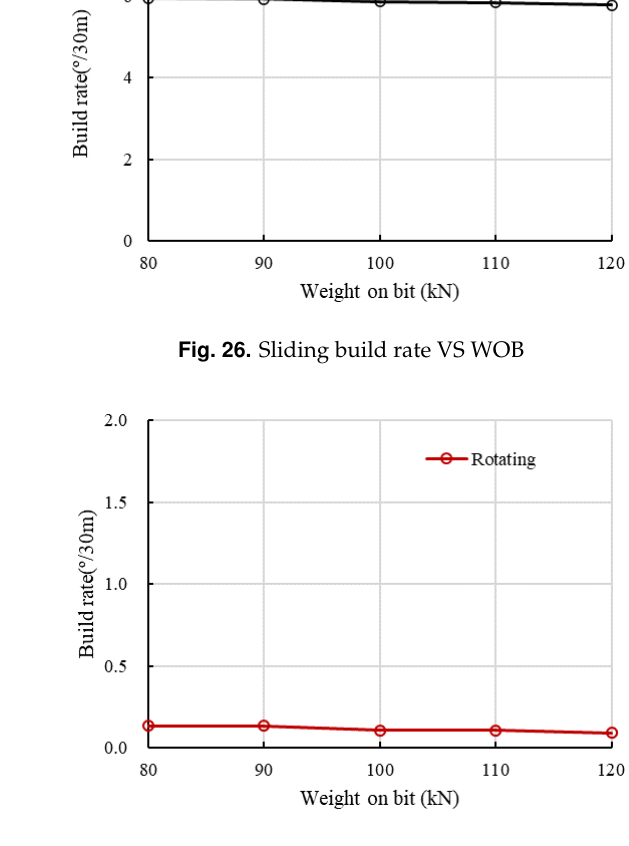
Fig. 27. Rotating build rate VS